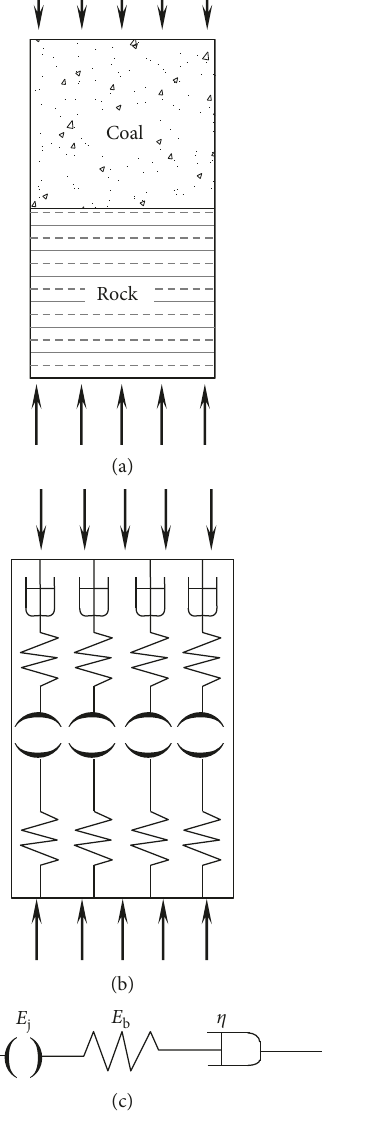
Figure 11: The deformation mechanism of the rock-loose coal composite system without bolt: (a) geological model of RCB(0); (b) physical model of RCB(0); (c) deformation mechanism.